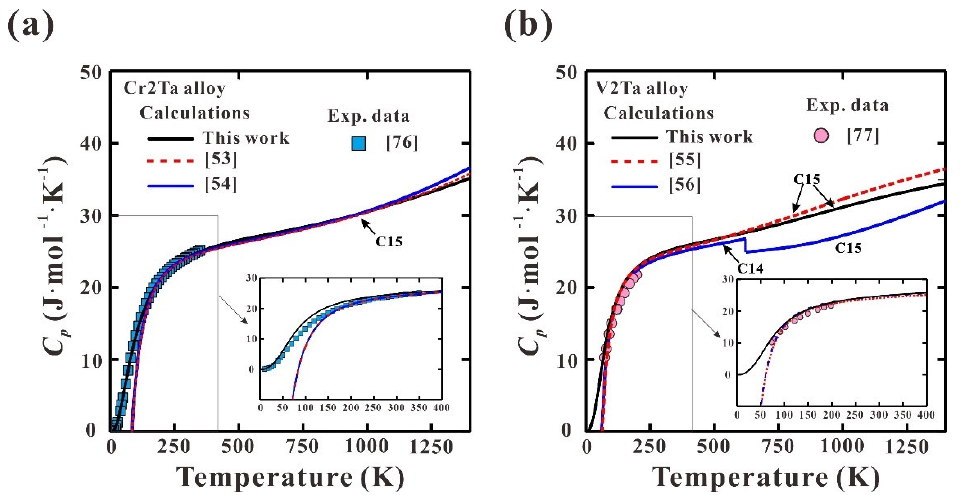
Figure 5. Calculated C p for ( a ) Cr2Ta and ( b ) V2Ta alloys from 0 to 1400 K along with the reported data [76,77].